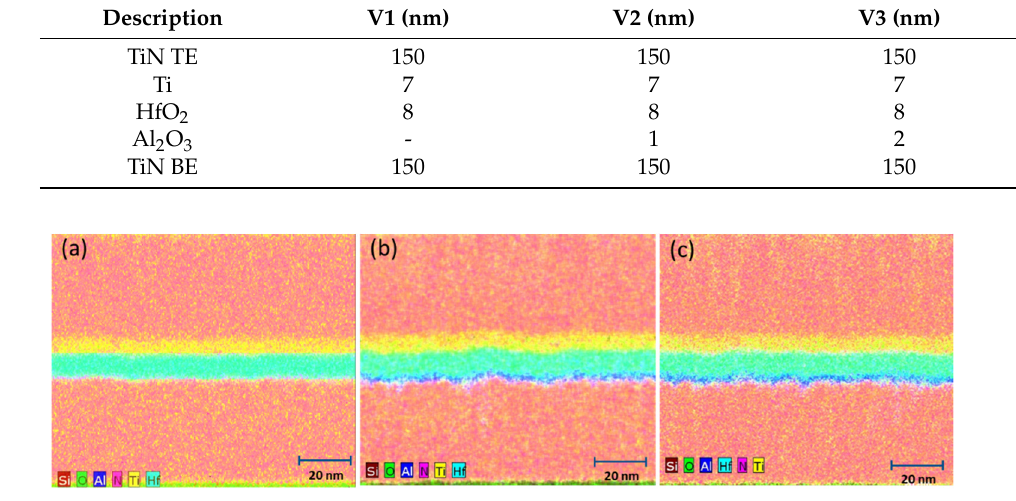
Figure 2. Cross-sectional TEM images with EDX elemental mapping of memristor modules in ( a ) V1 ( b ) V2 and ( c ) V3 variants.